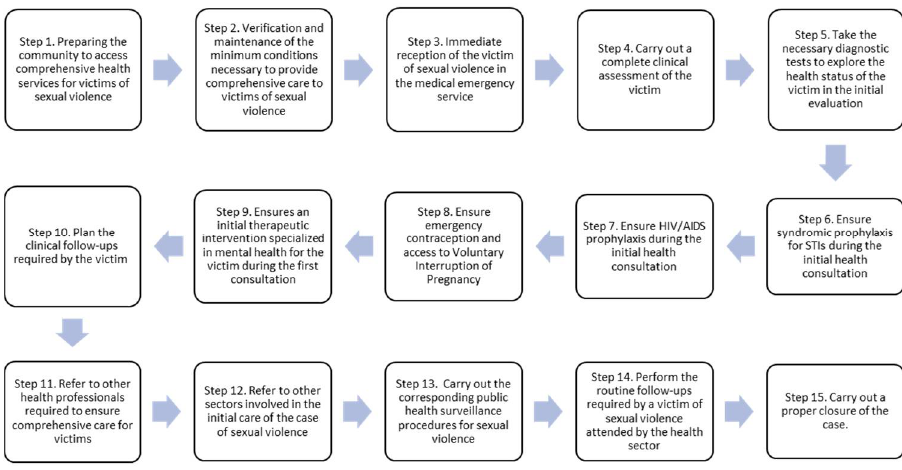
Figure 1. Comprehensive Health Care Protocol for Victims of Sexual Violence. Fundamental Steps in the Comprehensive Care of Victims of Sexual Violence.